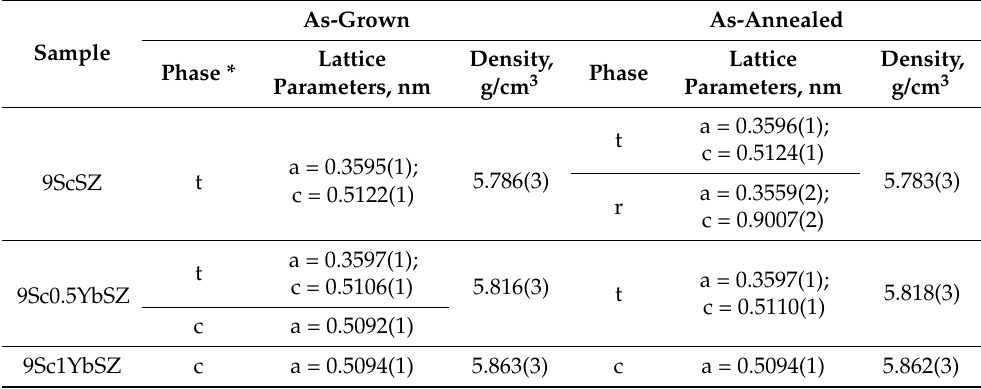
Table 1. Phase composition, lattice parameters and density of (ZrO 2 ) 0.91 − x (Sc 2 O 3 ) 0.09 (Yb 2 O 3 ) x crystals before and after annealing at 1000 ◦ C for 400